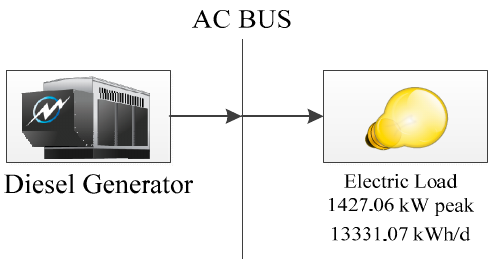
Figure 6. Conventional diesel generators only system.